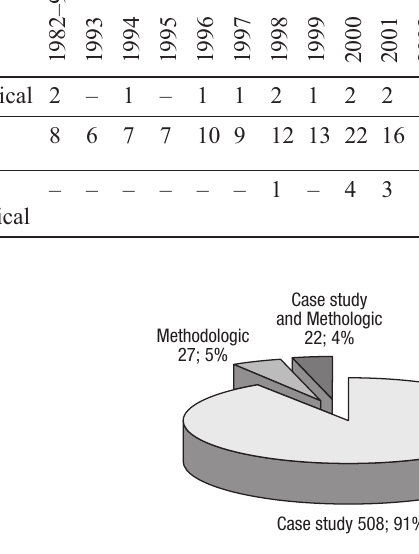
Fig. 3. Approaches in SWOT papers